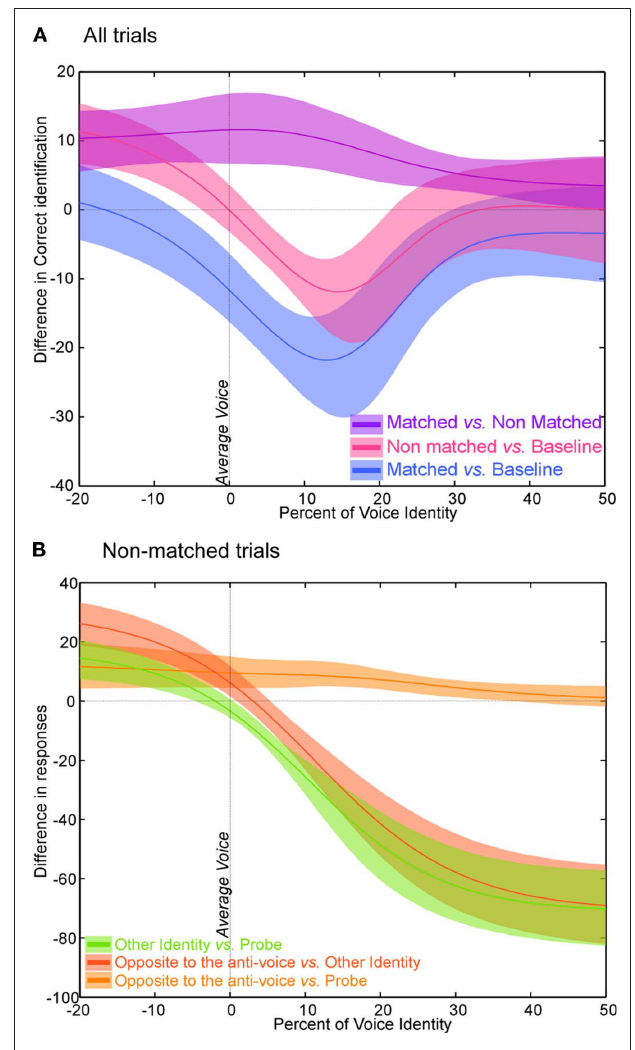
Figure 2 | experiment 1 – Statistical analysis (A) Statistical analysis. CI (shade) and plot of the difference in percent correct recognition (line) for 95% matched trials vs. baseline (blue), non-matched trials vs. baseline (pink), and matched trials vs. non-matched trials (purple). Note that both matched and non-matched adaptors induce a perceptual change compared to baseline, yet a stronger effect is seen for matched anti-voices. (B) Statistical analysis for non-matched trials only. CI (shade) and plot of the difference (line) between 95% responses according to the identity of the adapting stimulus (anti-voice) vs. identity of the probe (orange), identity of the adapting stimulus vs. other identity (red), and identity of the probe vs. other